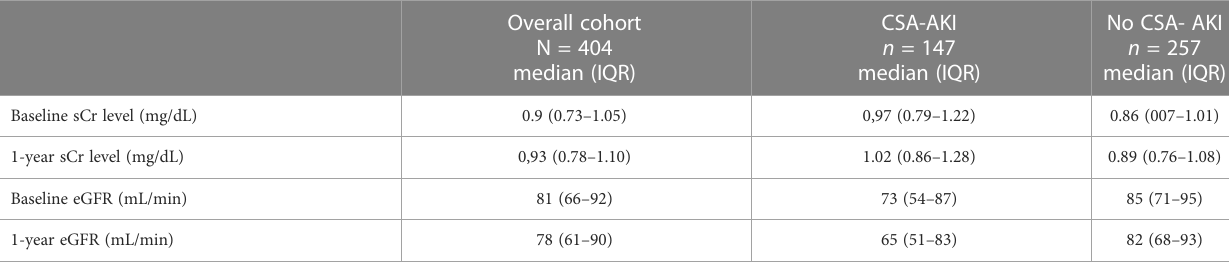
TABLE 2 Changes in sCr level and eGFR in the overall cohort, CSA-AKI, and no-CSA-AKI cohort.